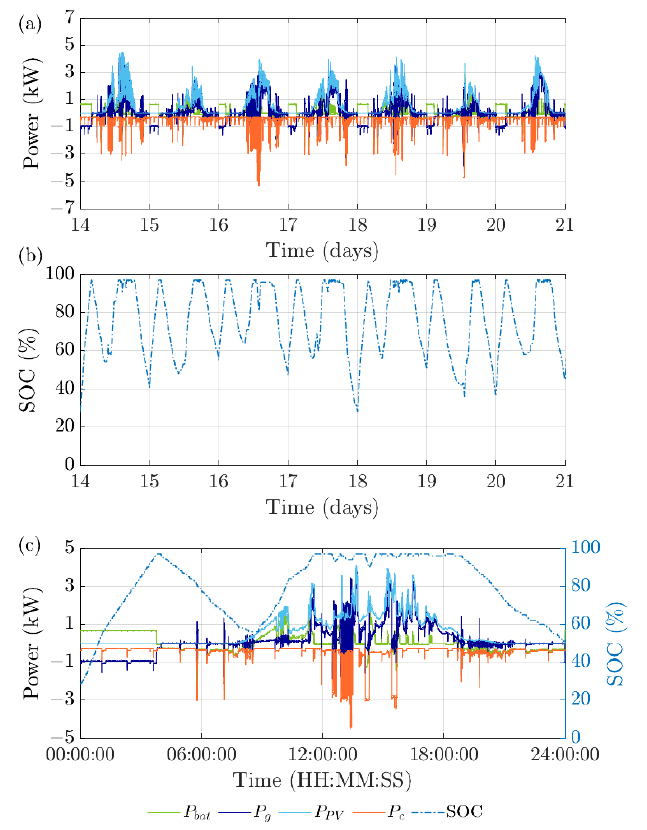
Figure 11. Experimental results of the SLB self-consumption installation: ( a ) SL battery power ( P bat ), grid power ( P g ), PV generation power ( P PV ), load power ( P c ) during one week; ( b ) battery SOC during one week; ( c ) power and SOC during a day [41]. Reprinted with permission of the author.